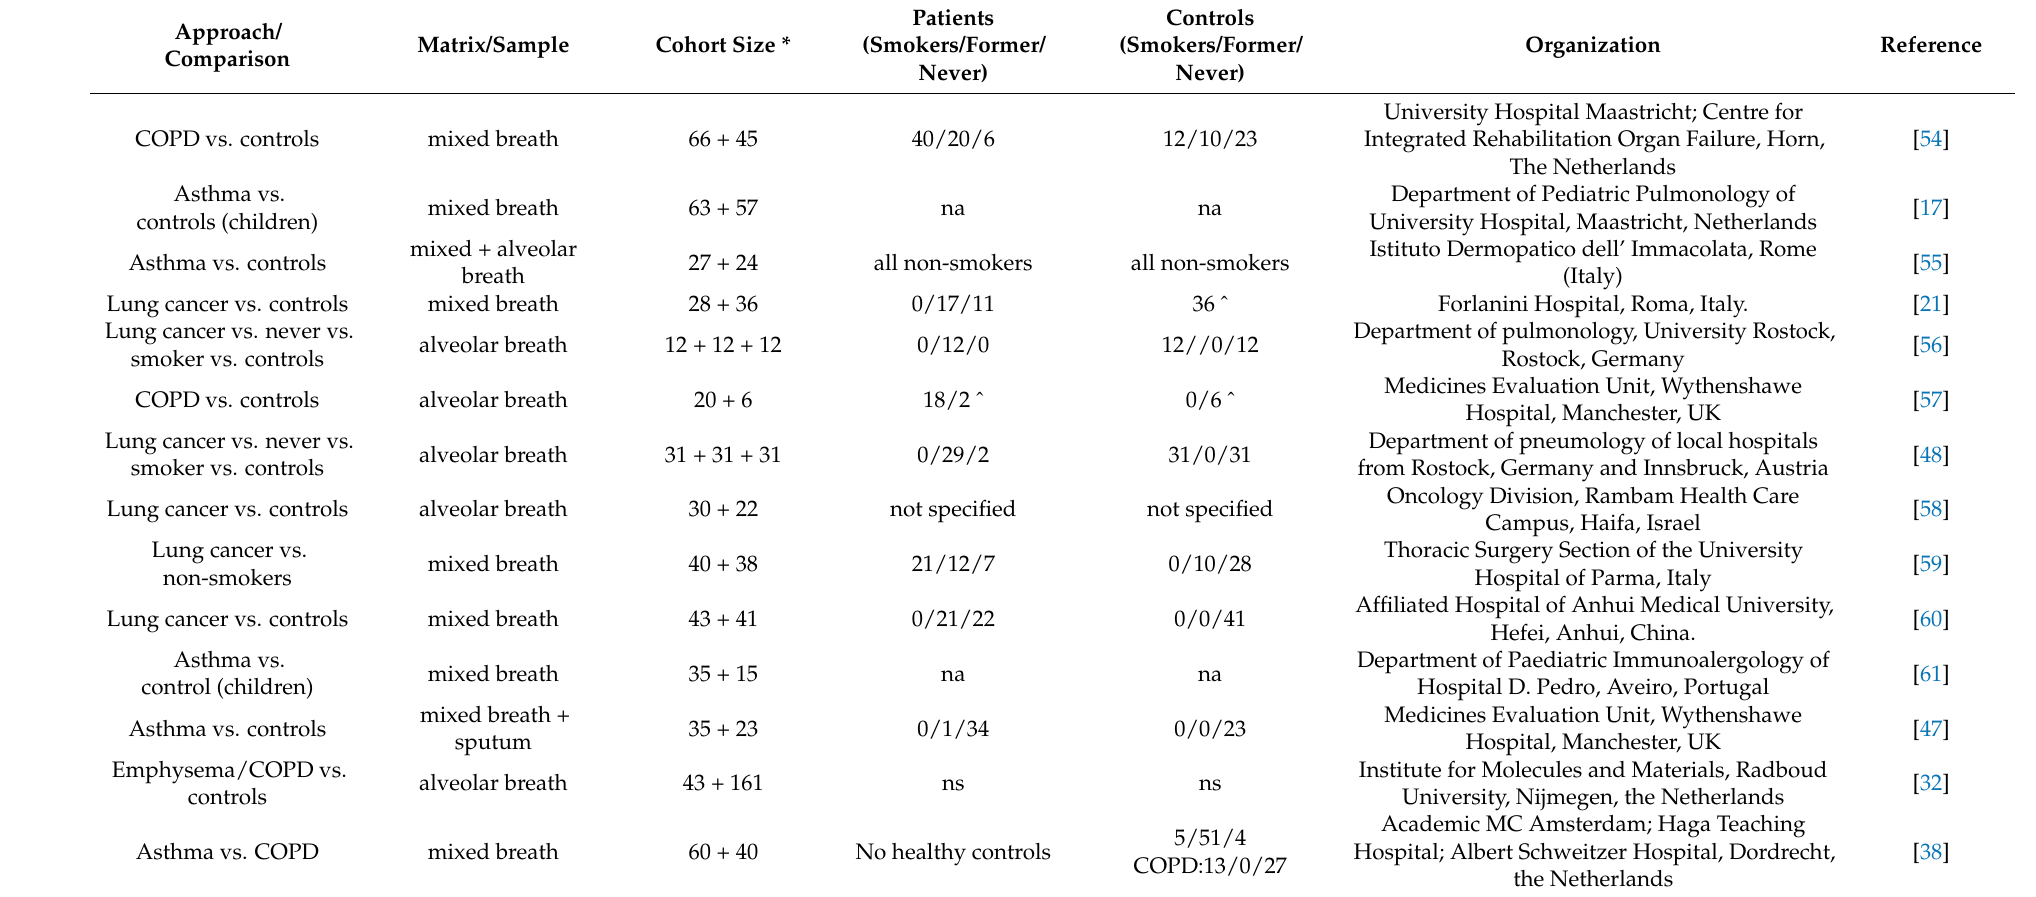
Table 1. General view of included clinical studies in terms of: approach, number of subjects and